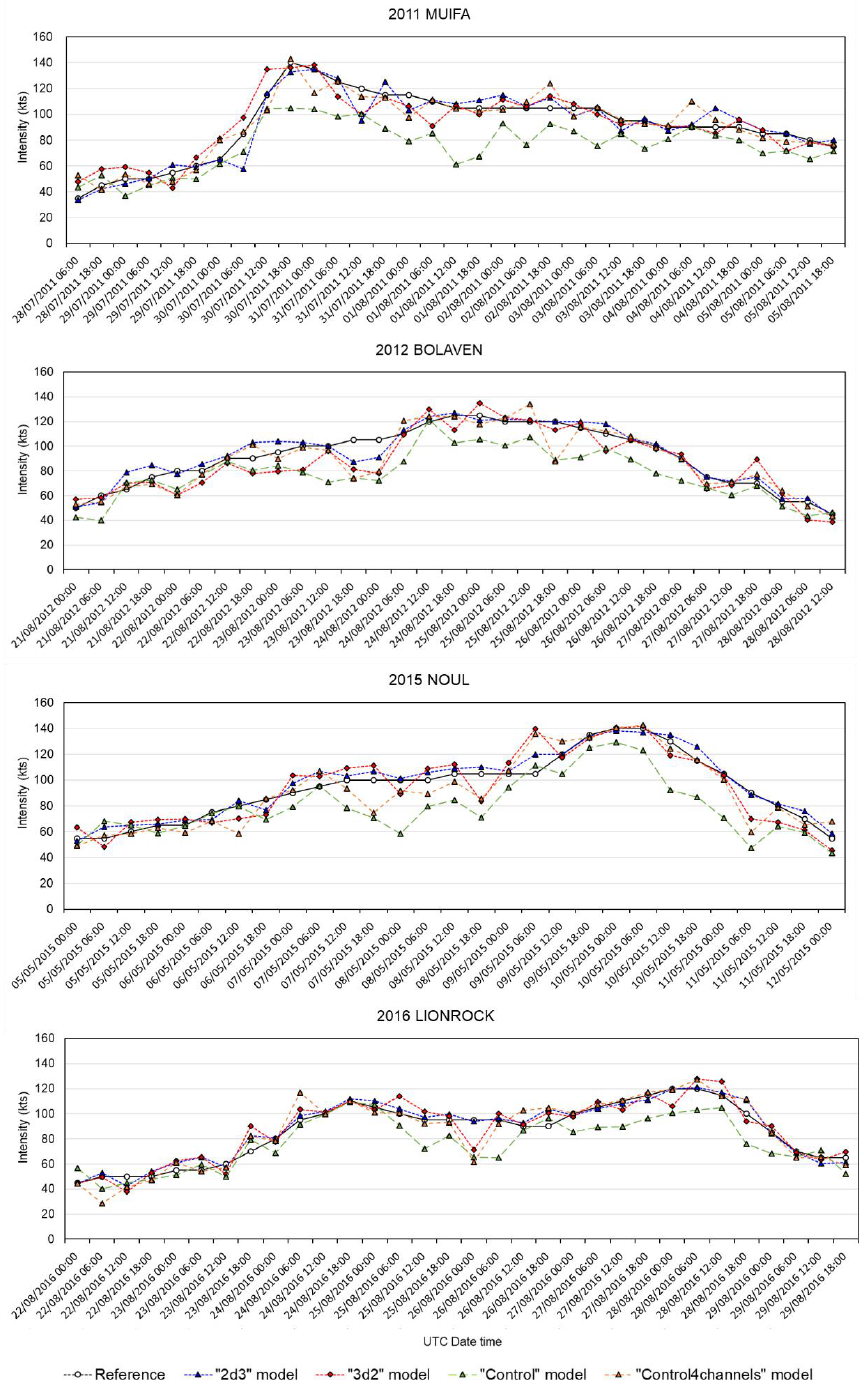
Figure 8. Time-series comparison of the validation results of four models (‘2d3’ and ‘3d2’ models which are proposed by this study and ‘Control’ and ‘Control4channels’ model, respectively) with JTWC best track data of typhoon MUIFA in 2011, BOLAVEN in 2012, NOUL in 2015, and LIONROCK in